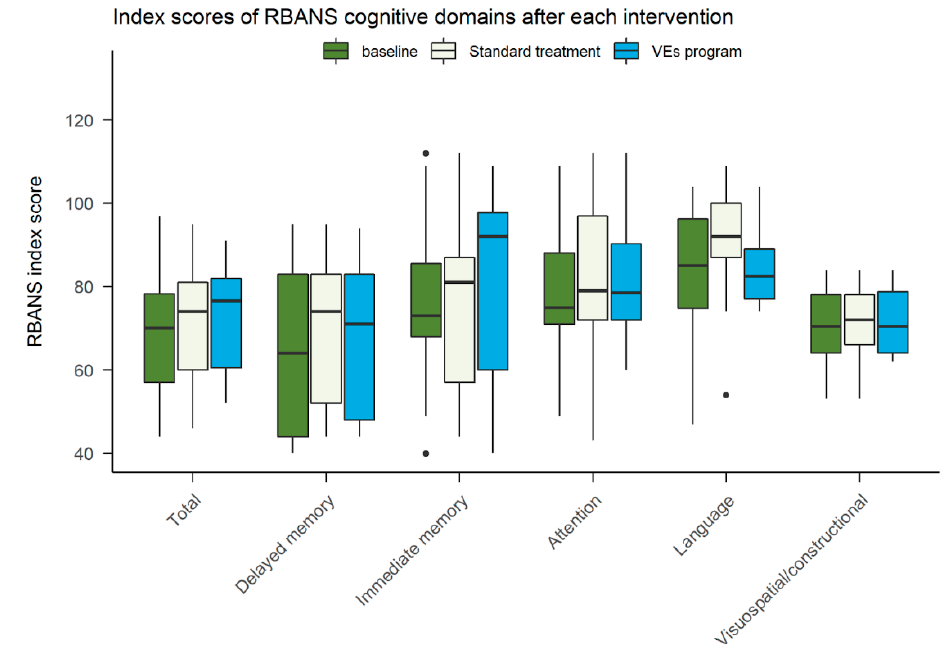
Figure 4. Summative results for RBANS cognitive domains (index scores) for each treatment. Box- plots represent the following information: the line is plotted at the median, the box extends from 25th to 75th percentiles, the whiskers are drawn up/down to the 10th and 90th percentile, and points represent the outliers. Legend: RBANS—Repeatable Battery for the Assessment of Neuropsycho- logical Status.